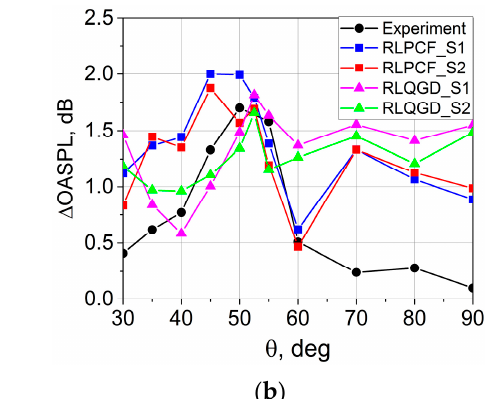
Figure 10. A scheme showing the two open control surfaces surrounding the jet (divergence of ve-